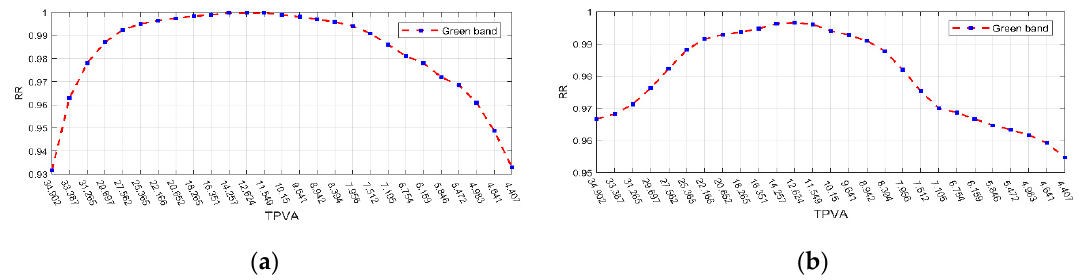
Figure 13. Recognition rates (RR) with different acutance (corresponding to δ ) for every band (spectrum) of HPV using different local texture patterns. Results using the feature extraction methods of ( a ) CompCode; ( b ) deep features.